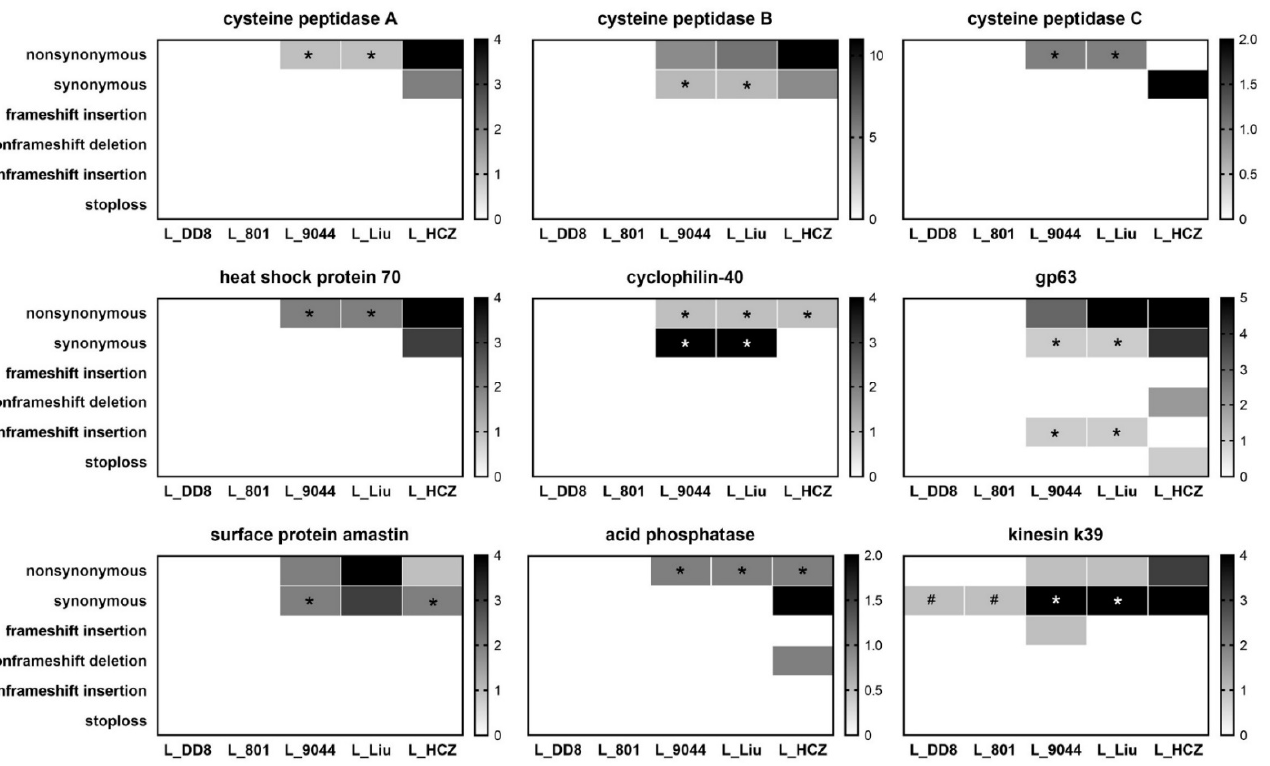
Figure 8. Mutation analysis of virulence genes in five Leishmania isolates. * Means that in this type of mutation, the gene sites, numbers and bases of mutations in L_9044, L_Liu and L_HCZ were completely consistent. # Means that in this type of mutation, the gene sites, numbers and bases of mutations in L_DD8 and L_801 were completely consistent.